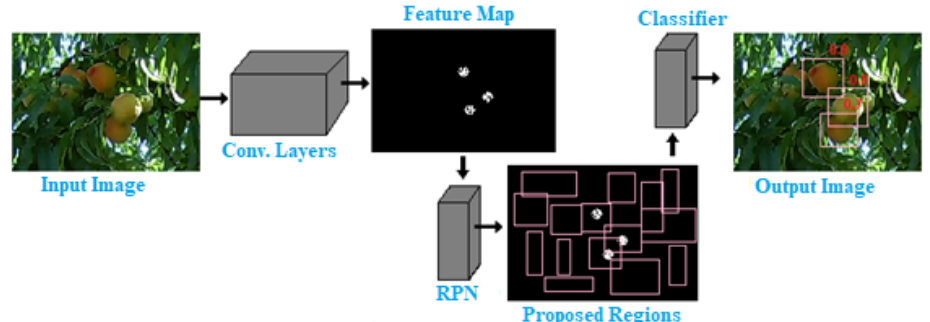
Figure 5. Faster R-CNN in the context of fruit